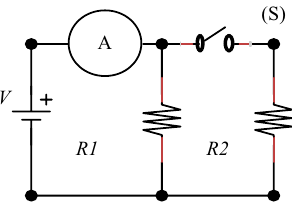
Fig. 2. The function of the switch and the variation of the